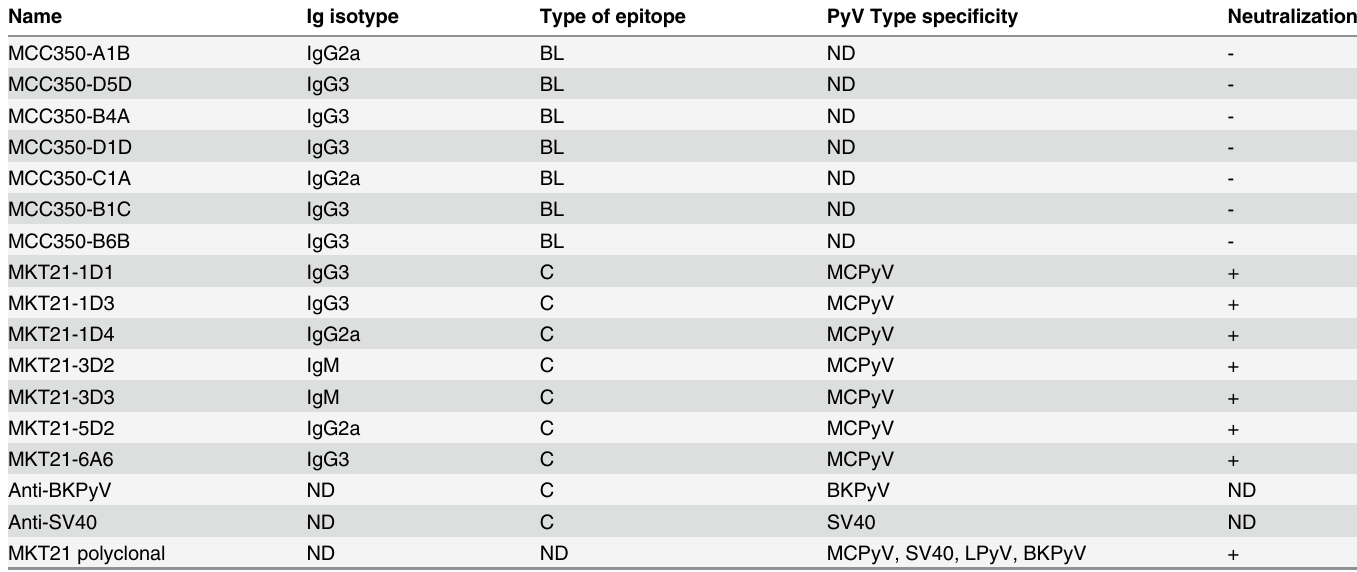
Table 2. Characteristics of 14 anti-MCPyV mAbs produced with VP1 from MCC350 and MKT21 strains. BL, buried linear, C, conformational.